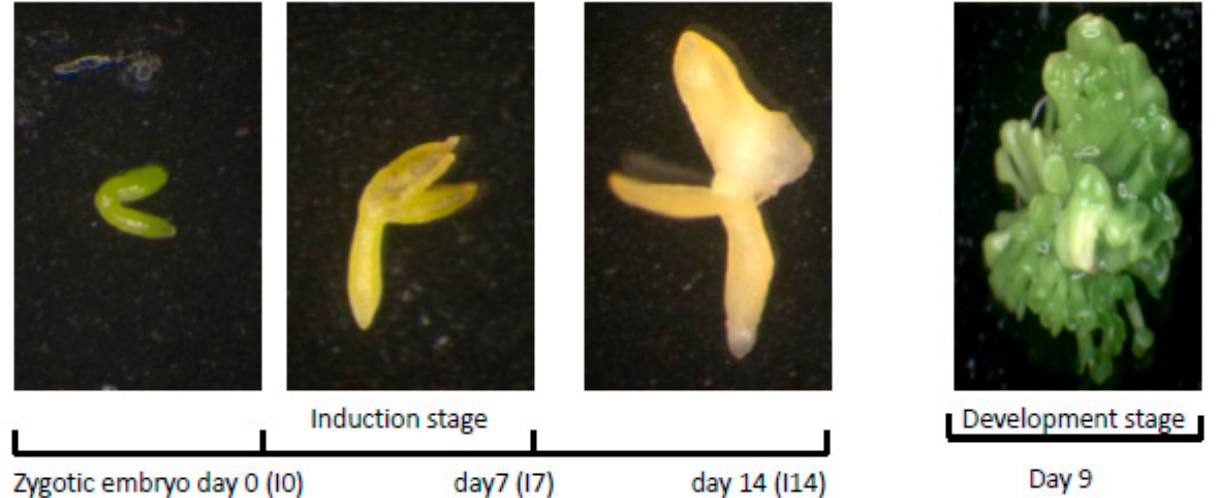
Figure 1. Schematic representation of the somatic embryogenic process in Arabidopsis . Immature zygotic embryos were cultured for 14 days on a 2,4-D-containing induction medium required for the formation of embryogenic tissue by immature embryos. Continuation of embryo development was achieved by transferring the explants on development medium devoid of 2,4-D. Fully developed somatic embryos were visible after 9